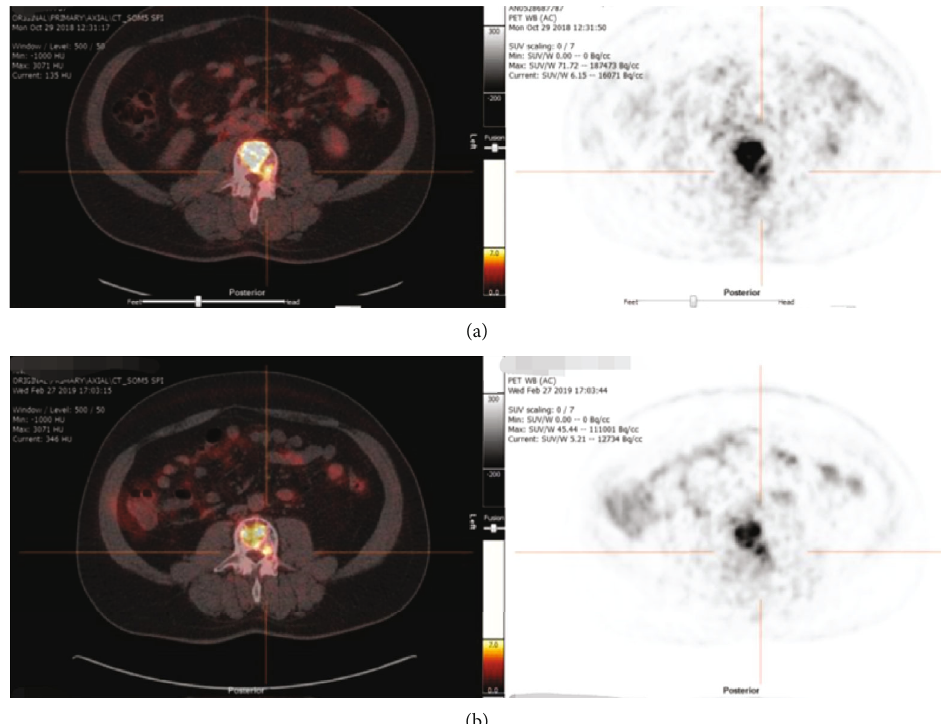
Figure 1: 18 F-FDG PET/CT scan showing the di ff erence in SUV maximum for lesion located in C6 at the moment of diagnosis (a) vs SUV maximum for same location after 3-cycle of Lenvatinib oral treatment (b). The decrease was quanti fi ed in